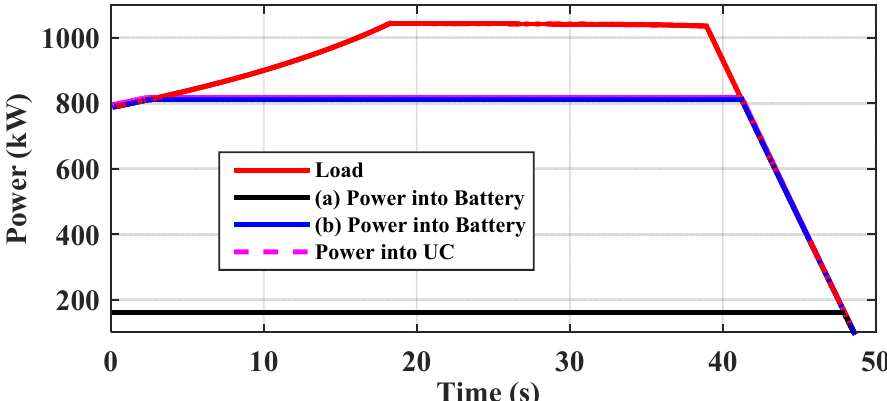
Figure 18. Comparison for regenerative power capture between UC and battery. Table 3. Configuration and specification of UC for hybridization with FC.